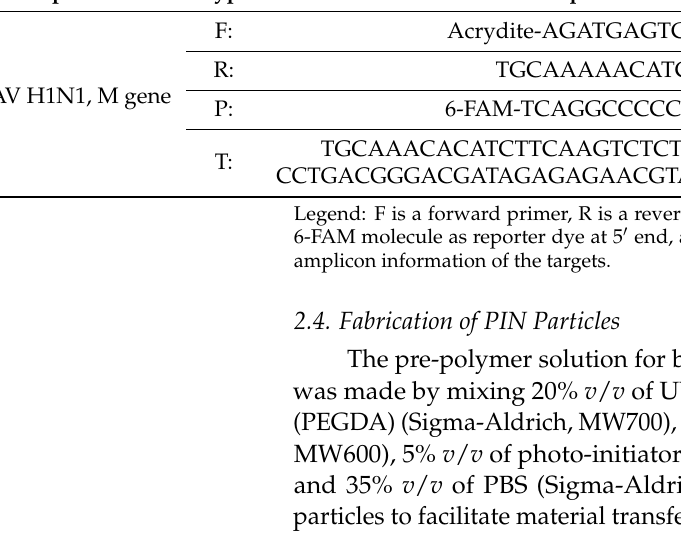
Table 1. Oligonucleotide primers, probes, and templates used in this study. Species